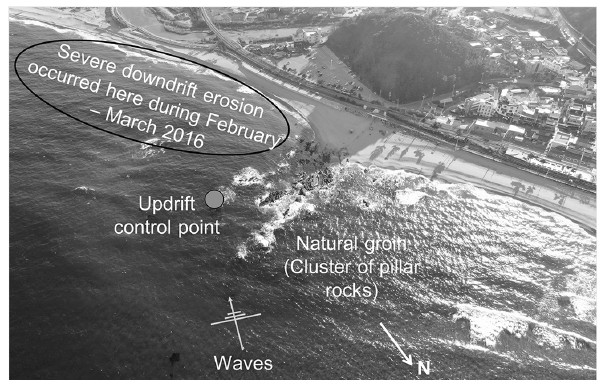
Figure 3. Location of pillar rocks seaward of Jeongdongjin Beach, where downdrift erosion had